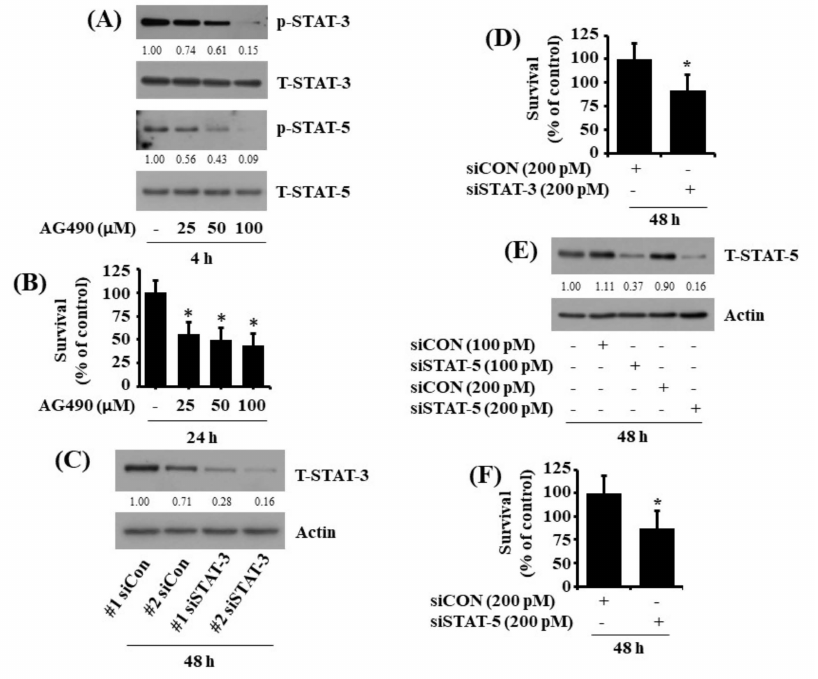
Figure 5. Effects of AG490 or STAT-3 or STAT-5 on the expression and phosphorylation of STAT-3 and STAT-5 in HuCCT-1 cells. ( A ) HuCCT-1 cells were treated with AG490 at the indicated concentrations for 4 h. Whole-cell lysates were prepared and analysed for levels of p-STAT-3, T-STAT-3, p-STAT-5, T-STAT-5, or β -actin by Western blotting. ( B ) HuCCT-1 cells were treated with AG490, a pan-inhibitor of STATs, at the indicated concentrations for 24 h, then measured the number of surviving cells by cell count assay. The cell count assay was performed in triplicate. Data are means ± SE of three independent experiments. * p < 0.05 compared to the control at the indicated concentrations. ( C ) HuCCT-1 cells were transfected with 200 pM of control siRNA (siCon) or STAT-3 siRNA (siSTAT-3) for 48 h. Whole-cell lysates were prepared and analyzed for T-STAT-3 or β -actin by Western Blotting. ( D ) HuCCT-1 cells were transfected with 200 pM of control siRNA (siCon) or STAT-3 siRNA (siSTAT-3) for 48 h, followed by measurement of the number of surviving cells by cell count assay. The cell count assay was performed in triplicate. Data are means ± SE of three independent experiments. * p < 0.05 compared to the value of siCon or siSTAT-3 at the indicated time. ( E ) HuCCT-1 cells were transfected with 200 pM of control siRNA (siCon) or STAT-5 siRNA (siSTAT-5) for 48 h. Whole-cell lysates were prepared and analyzed for T-STAT-5 or β -actin by Western Blotting. ( F ) HuCCT-1 cells were transfected with 200 pM of control siRNA (siCon) or STAT-5 siRNA (siSTAT-5) for 48 h, followed by measurement of the number of surviving cells by cell count assay. The cell count assay was performed in triplicate. Data are means ± SE of three independent experiments. * p < 0.05 compared to the value of siCon or siSTAT-5 at the indicated